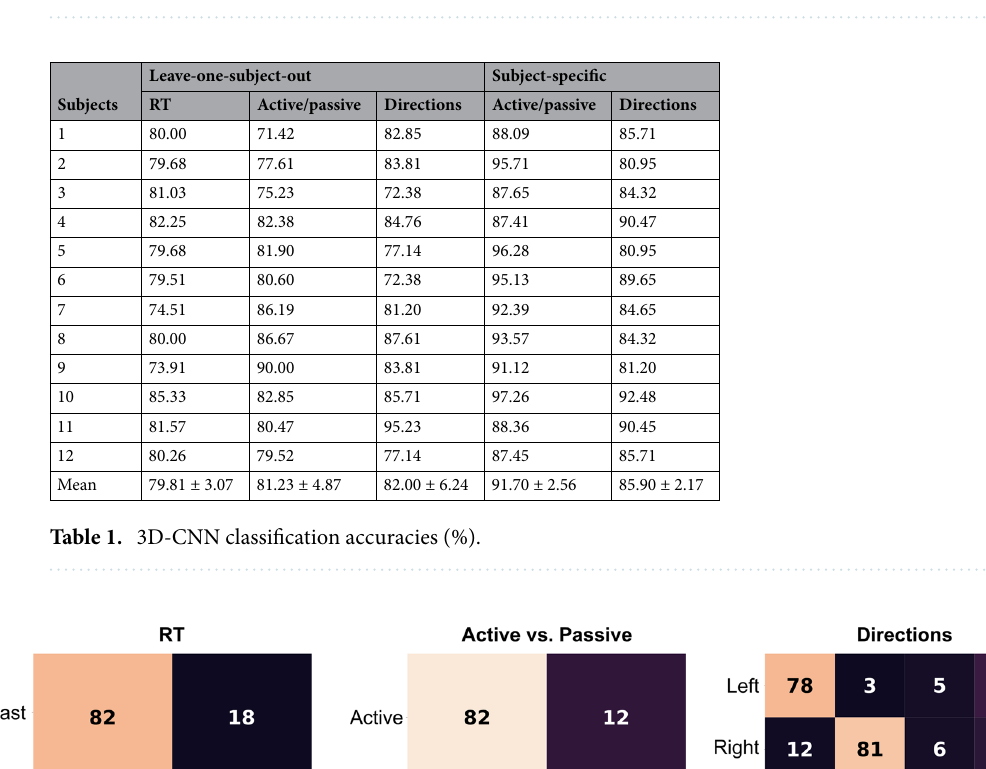
Figure 3. The proposed 3D-CNN architecture. Here, the 5-layer network received topography-preserving 3D EEG inputs and performed convolutions in both sensor and time spaces. Extracted features were fed to the classification layer for class prediction.